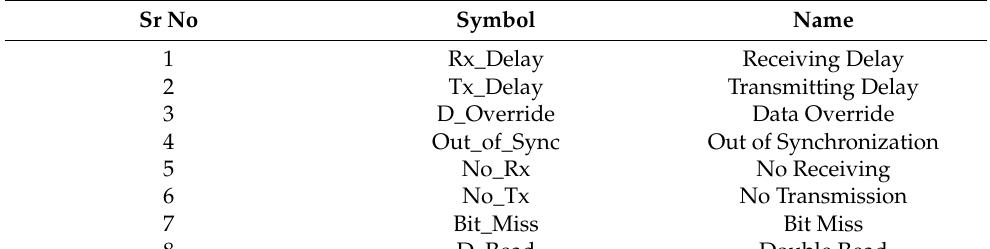
Table 2. Synchronization Errors.